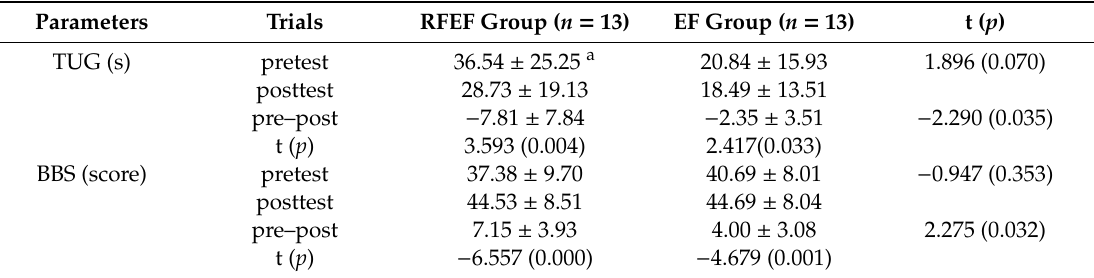
Table 3. Di ff erence on the balance ( N =